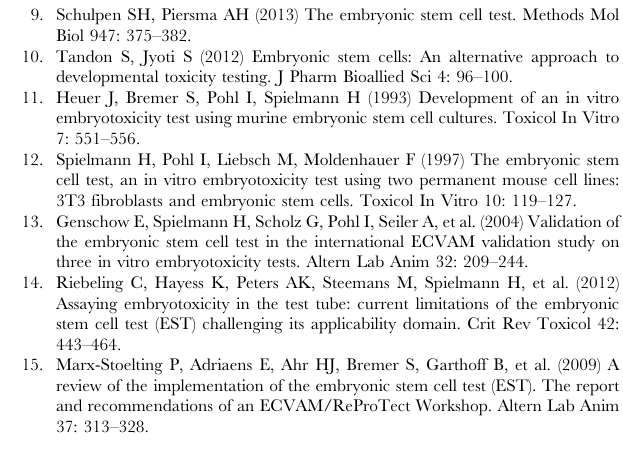
Table S1 Full list of DEGs across different time points during ESC differentiation. Using stringent criteria of Bonferroni-adjusted p , 0.05 and fold change (FC) . 2.0, a total of 1996 DEGs were found differentially expressed, with 1229 upregulated and 767 downregulated along the time course. Out of these probesets, 1675 were mapped to the DAVID database as annotated genes. Table S2 Full list of 541 (533 unique) GO terms in the biological process (BP) category at all levels (GO- TERM_BP_ALL) enriched by the 1996 DEGs identified during ESC differentiation. DAVID was used for the analysis using the 1996 DEGs identified during ESC differentiation (see text and Table S1 for details). The Mus musculus (mouse) whole genome was used as background. Statistical enrichment was determined through a modified Fisher’s exact test ( p , 0.05) and count threshold . 4. The column under ‘‘Count’’ indicates the number of DEGs involved in the specific GO term, while the column under ‘‘%’’ indicates the number of DEGs involved in the GO term as a percentage of the total number of annotated DEGs (1675). Table S3 List of 96 DEGs that were differentially expressed throughout the ESC differentiation process. Gene expression profiles at each time point were compared with the starting point (0 h after EB formation) using pairwise t -test, and DEGs were selected by p , 0.05 and FC . 2.0. The common DEGs of all the time points were mapped to DAVID database to find the annotated genes. Table S4 Full list of 162 (159 unique) GO terms in the biological process (BP) category at all levels (GO- TERM_BP_ALL) enriched by the 96 DEGs identified throughout ESC differentiation. DAVID was used for the